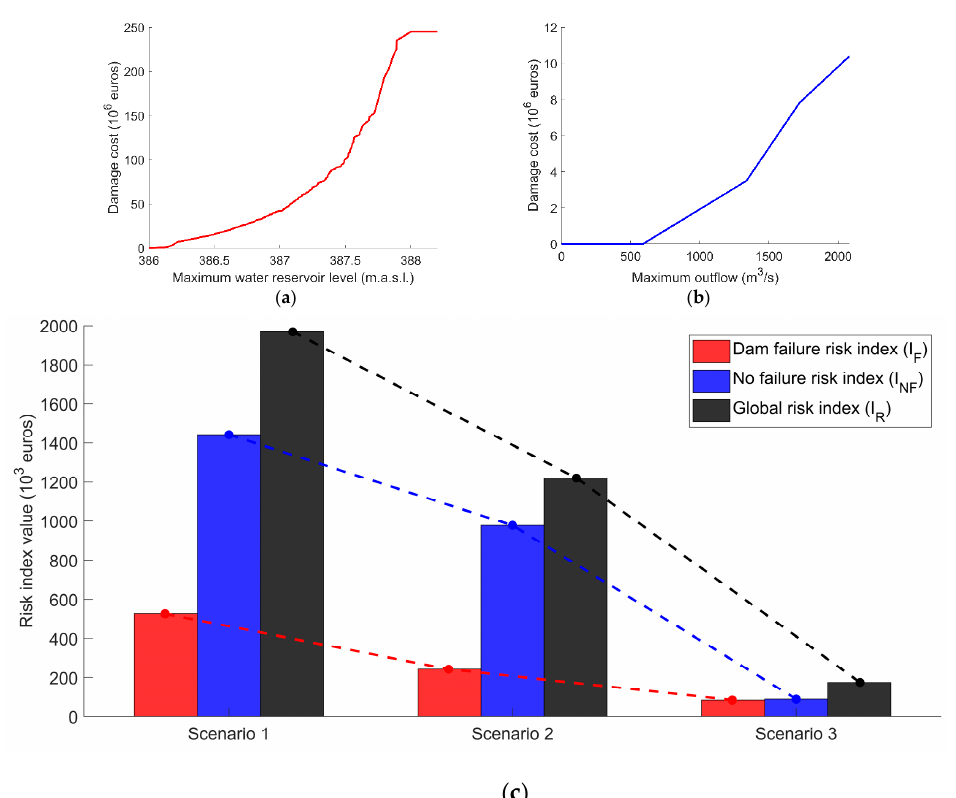
Figure 5. Damage cost curves. ( a ) Damage cost curves associated with maximum water reservoir levels. ( b ) Damage cost curves associated with maximum outflows. ( c ) Values of dam failure (I F , red bars), non-failure (I NF , blue bars), and global (I R , black bars) risk index, for each of the three scenarios. Colored lines are added for a better comparison between the scenarios and the risk indices.